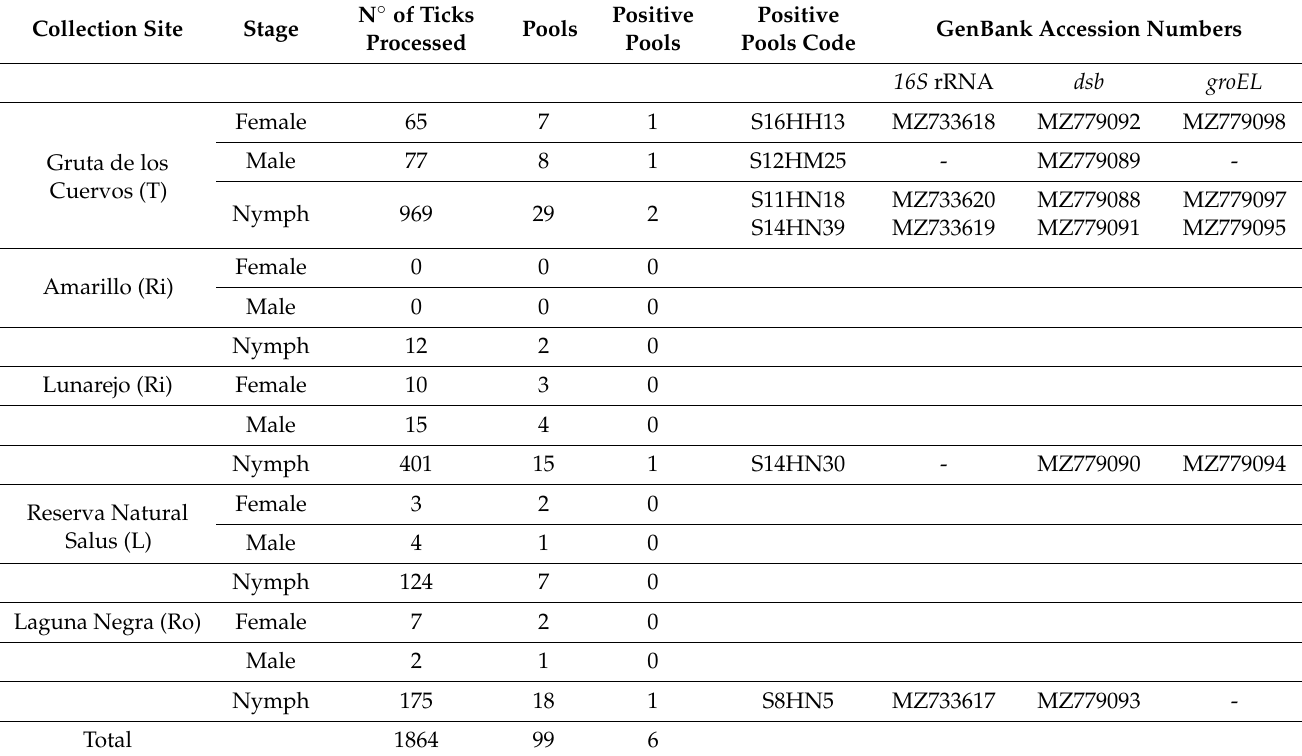
Table 2. Data of Haemaphysalis juxtakochi collected in vegetation for each site and processed for detection of “ Candidatus Ehrlichia